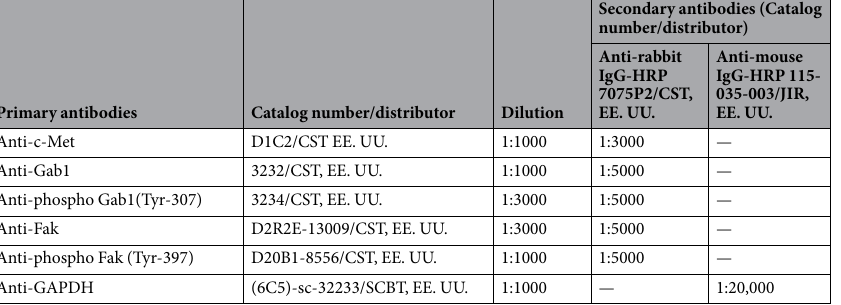
Table 2. Antibodies used in the study. CST: Cell Signaling Technology; SCBT: Santa Cruz Biotechnology; JIR: Jackson